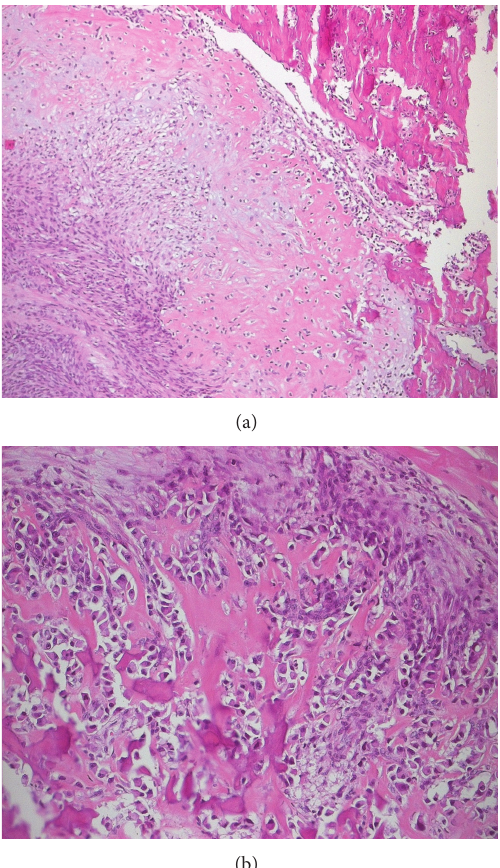
Figure 6: Focal areas of the tumour showed malignant cartilaginous change (a), osteoid and bone formation ((a) Stain: H&E, × 10, (b) Stain: H&E, ×